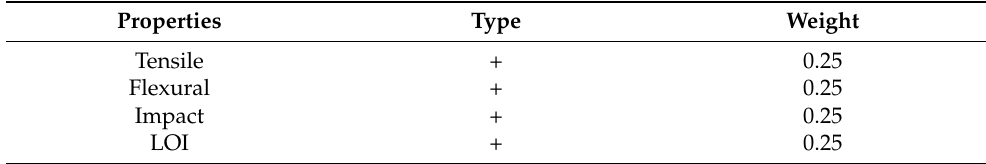
Table 2. Characteristics of